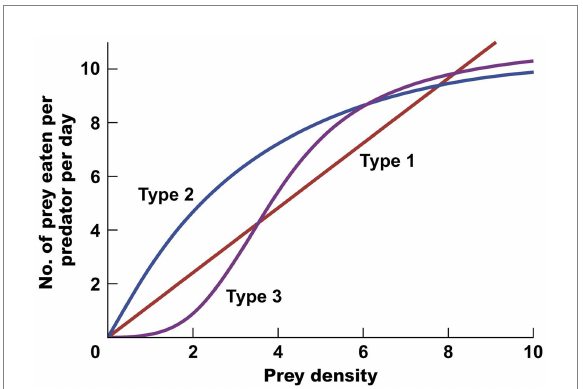
FIGURE 1 Three types of functional responses of a predator to different levels of prey density. Holling (1959) named these Type 1, 2, and 3, and for any particular predator–prey system, much research has gone into determining which of these 3 curves, if any, describe the data best. [From (Krebs, 2009), Figure